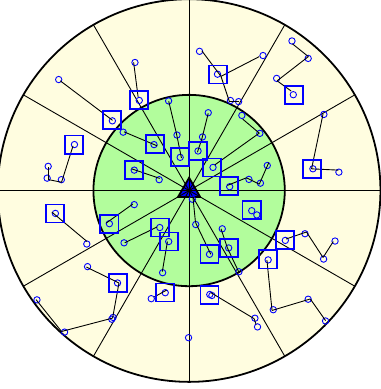
Figure 8. Chain construction for every sector with head node. Algorithm 2: Chain construction procedure for each sector